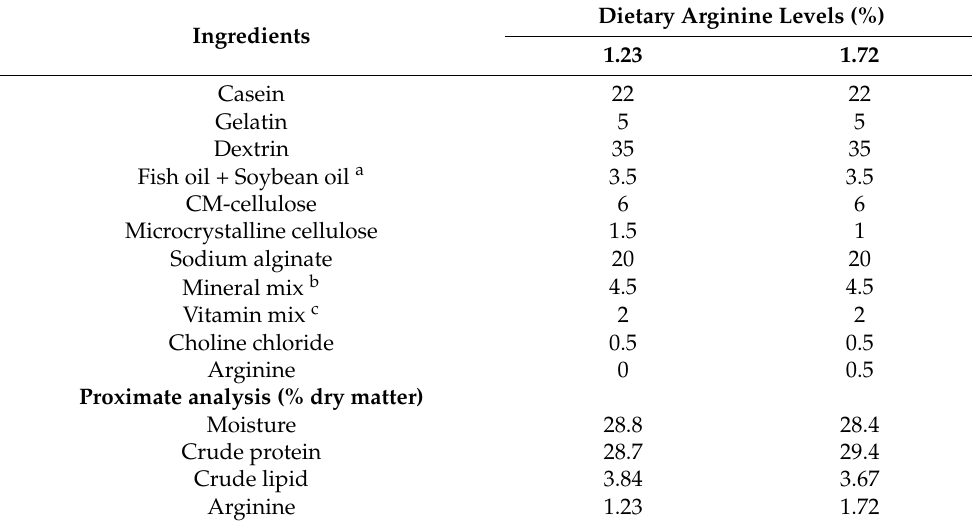
Table 3. Ingredients and proximate analysis of the experimental